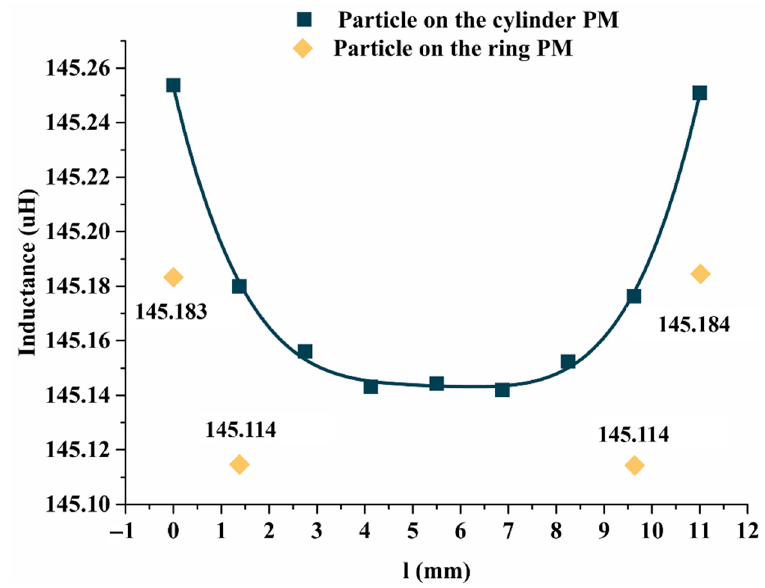
Figure 4. Effect of particle position on coil inductance. Table 1. Effects of detection unit with different structure type of permanent magnet.